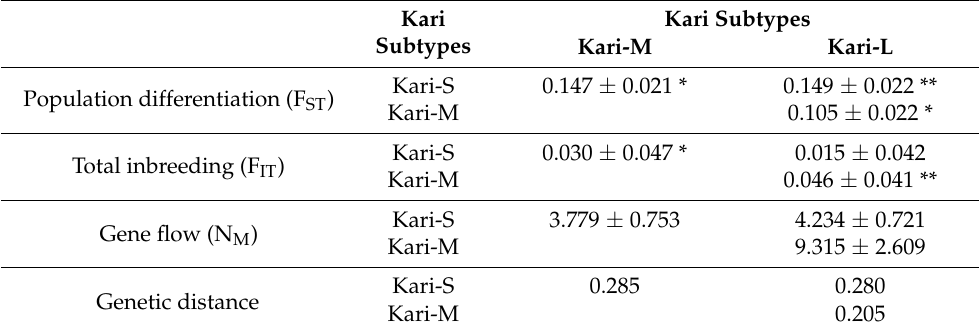
Table 4. Pairwise genetic association of the three Kari subtypes based on microsatellite data. Kari Subtypes